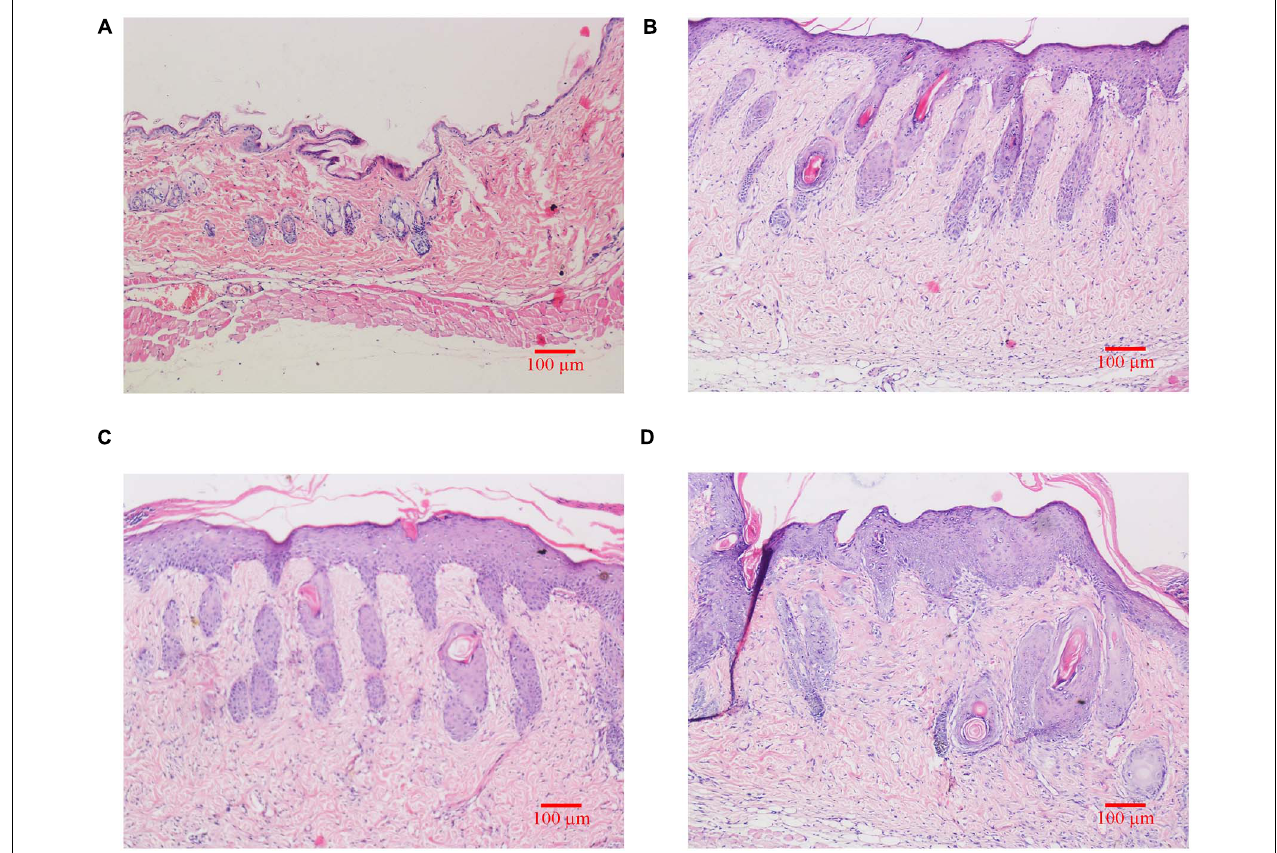
FIGURE 2 | Histological changes of dorsal skin in mice exposed to different doses of UVB irradiation. These show the magnification is 10 times under an optical microscope. (A) Control group; (B) The experimental group received radiation dose of 90 mJ/cm 2 ; (C) The experimental group received radiation dose of 180 mJ/cm 2 ; (D) The experimental group received radiation dose of 360 mJ/cm 2 .